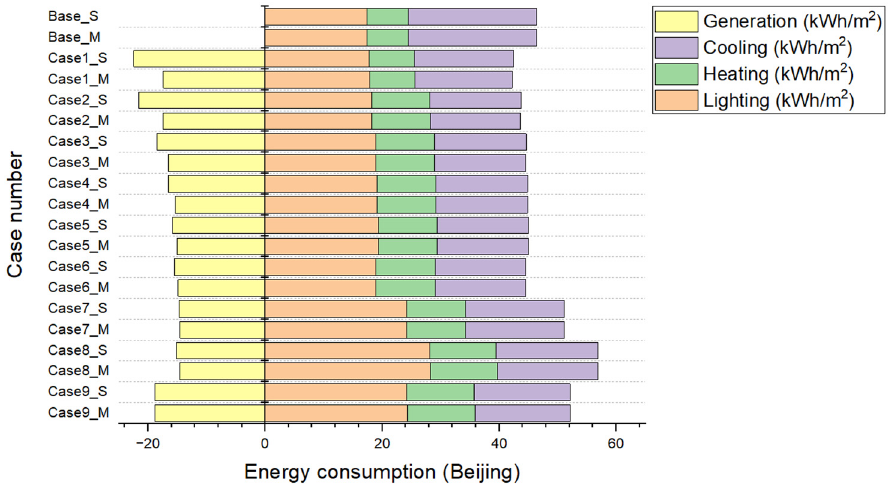
Figure 9. Energy consumption of single-story and multi-story buildings (in Beijing) with different PVSDs.